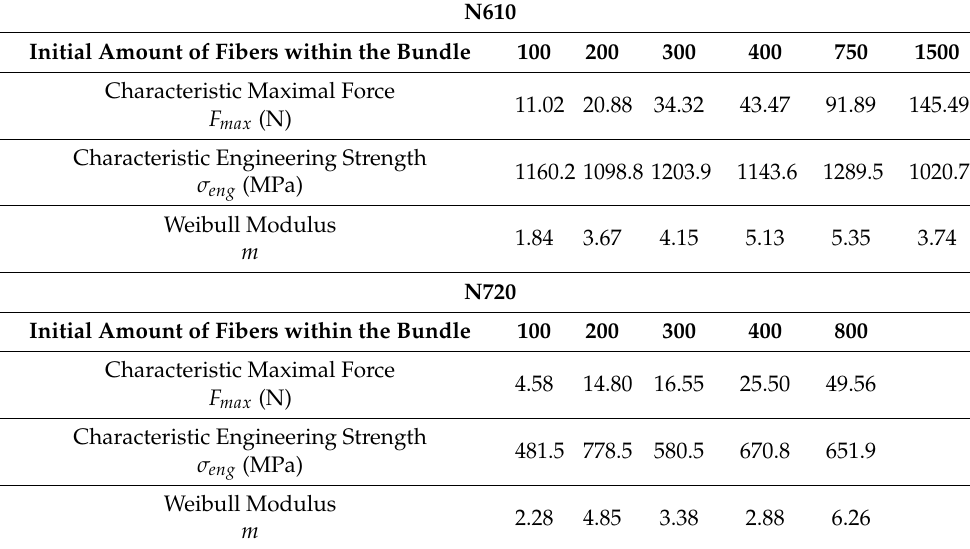
Table 3. Engineering strength experimental results for the fiber